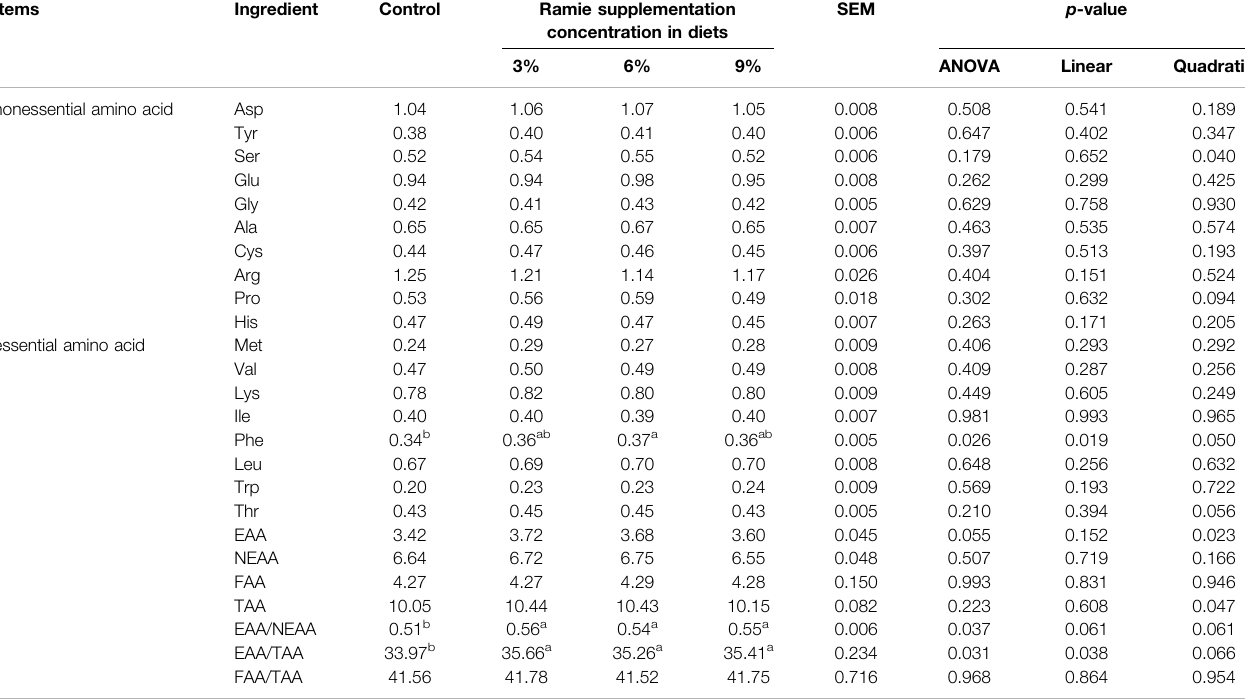
concentration in diets